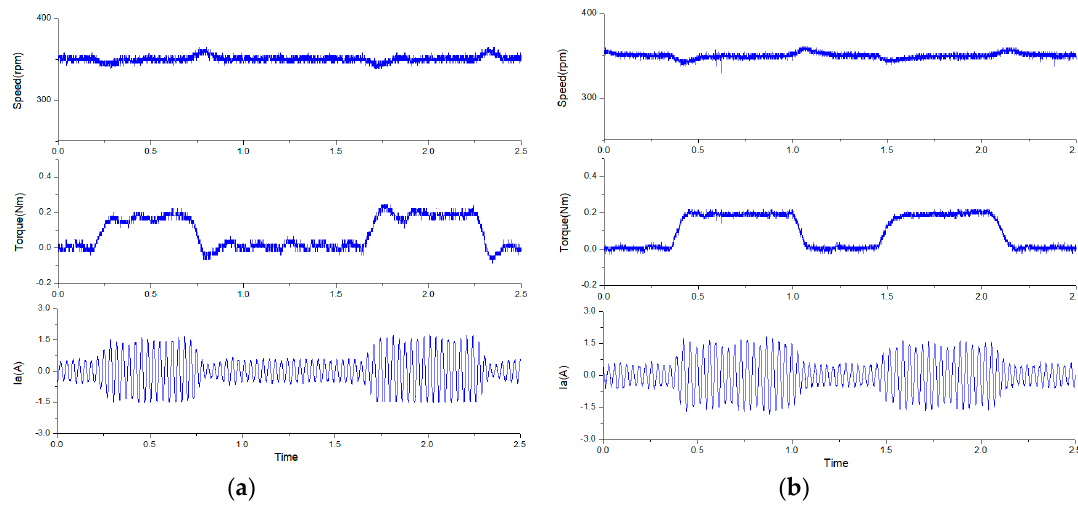
Figure 15. The dynamic response for disturbance load of 0.2 Nm at a speed of 350 rpm: ( a ) the traditional PI control, and ( b ) the proposed modified MPCC.